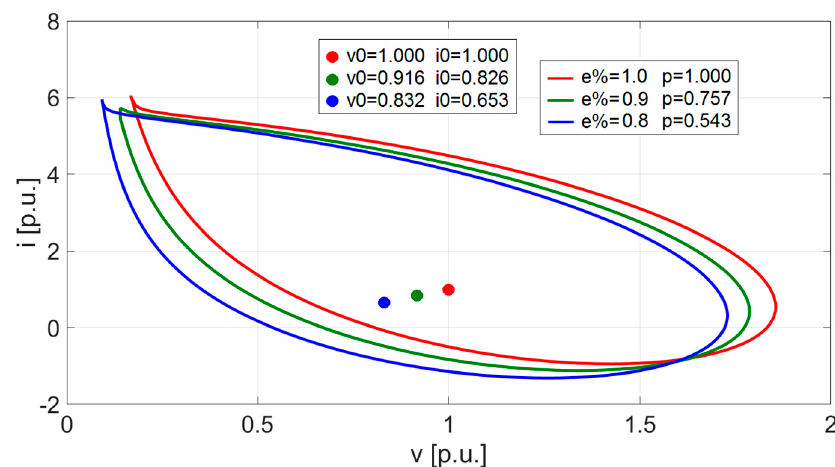
Figure 11. BA migration imposed by power reduction function.